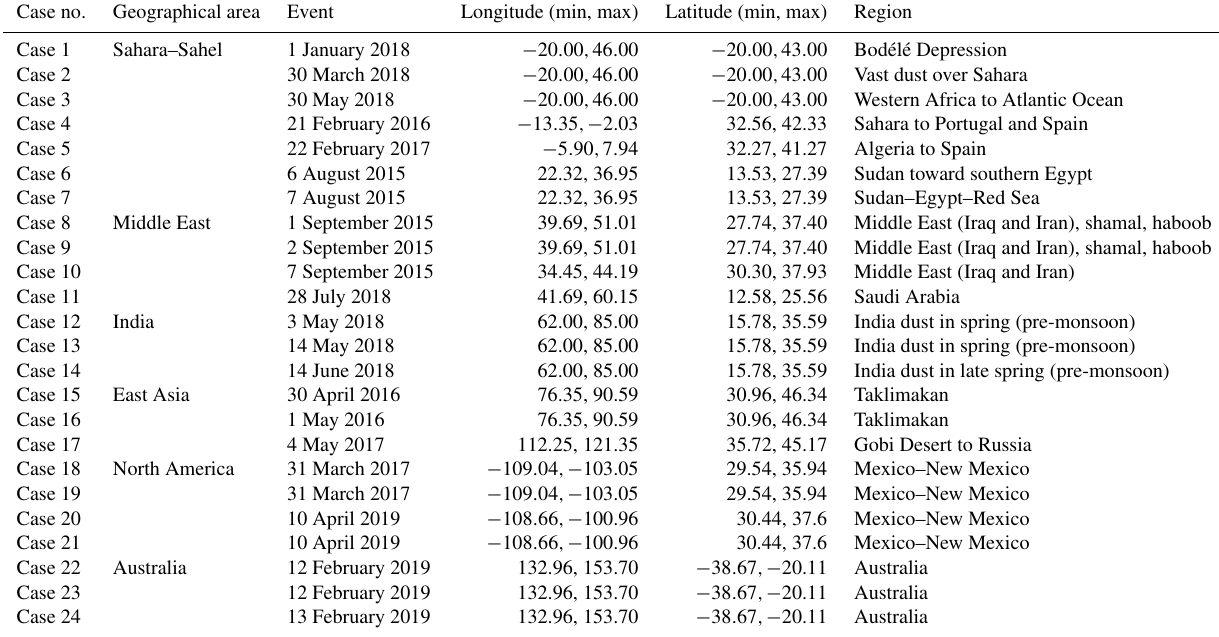
Table 2. Summary of information for selected dust episodes used in this study (Figs. 5, A1–A6). The corresponding aerosol plume height (based on CALIOP) and volume size distribution (based on AERONET version 3; Sinyuk et al., 2020) are additionally presented in Fig. S1. Case